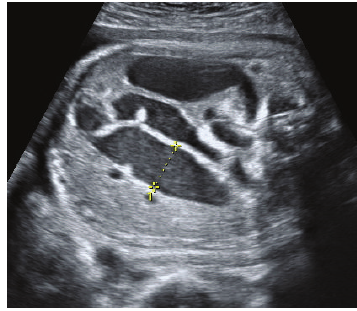
Figure 2: Intestinal loop dilatation with 18mm.